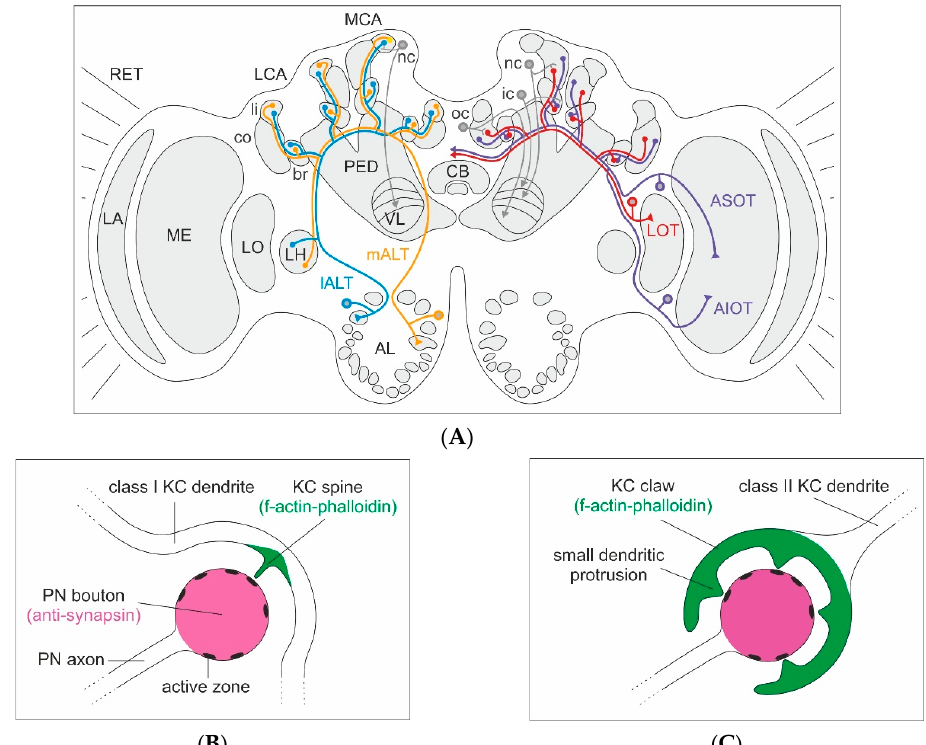
Figure 1. Olfactory and visual innervation of the medial (MCA) and lateral calyx (LCA) of the mushroom bodies (MBs), and the classification of Kenyon cells (KCs) in the honeybee brain. ( A ) Left brain hemisphere: Brain overview with innervation from projection neurons (PNs) of the medial (m-ALT, orange) and lateral (l-ALT, blue) antennal-lobe tracts to a spiny (class I) non-compact (nc) KC from the lip (li) of the MCA, with axonal projections to the lip layer of the vertical lobe (VL). Right brain hemisphere: PNs from the medulla (ME) project via the anterior superior (ASOT, purple) and anterior inferior optic tracts (AIOT, purple), as well as the lobula (LO) PNs via the lobular tract (LOT, red) (optic lobe tracts after [35]). Connections in the collar (co) with a spiny nc KC in the MCA with axonal projections to the visual layer of the VL, a spiny (class I) inner compact (ic) KC in the basal ring (br) projecting to the upper-most layer of the VL and a clawed (class II) outer compact (oc) KC projecting to the lower-most (gamma) layer of the VL. The KC axonal projections in the VL layers reflect the concentric organization of their dendrites in the MB calyx (KC projections after [28]). ( B ) Organization of an individual microglomerulus innervated by a class I KC. Schematic drawing of an individual PN synaptic bouton and innervation by a single spiny class I KC dendrite with one spine-like protrusion forming a synaptic contact at one active zone of the PN bouton. Anti-synapsin labeling colored in magenta and f-actin-phalloidin staining in green. ( C ) Organization of an individual microglomerulus innervated by a class II KC. Schematic drawing of a single PN synaptic bouton innervated by an individual claw of a class II KC dendrite with multiple dendritic protrusions forming synaptic contacts with multiple active zones of the PN bouton. Further abbreviations: AL: antennal lobe, CB: central body, LA: lamina, LH: lateral horn, PED: peduncle, PN: projection neuron, RET: retina.